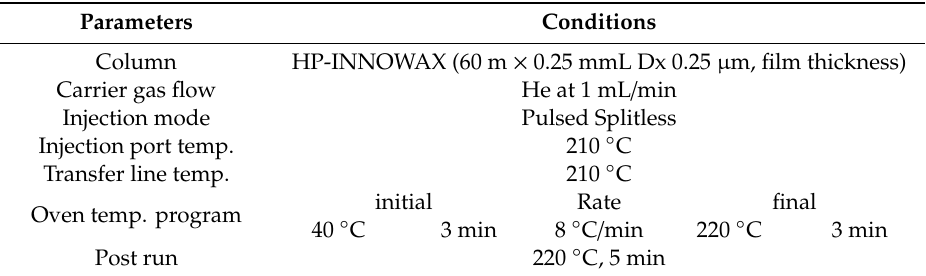
Table 1. The conditions for the operating parameters for NVOC.